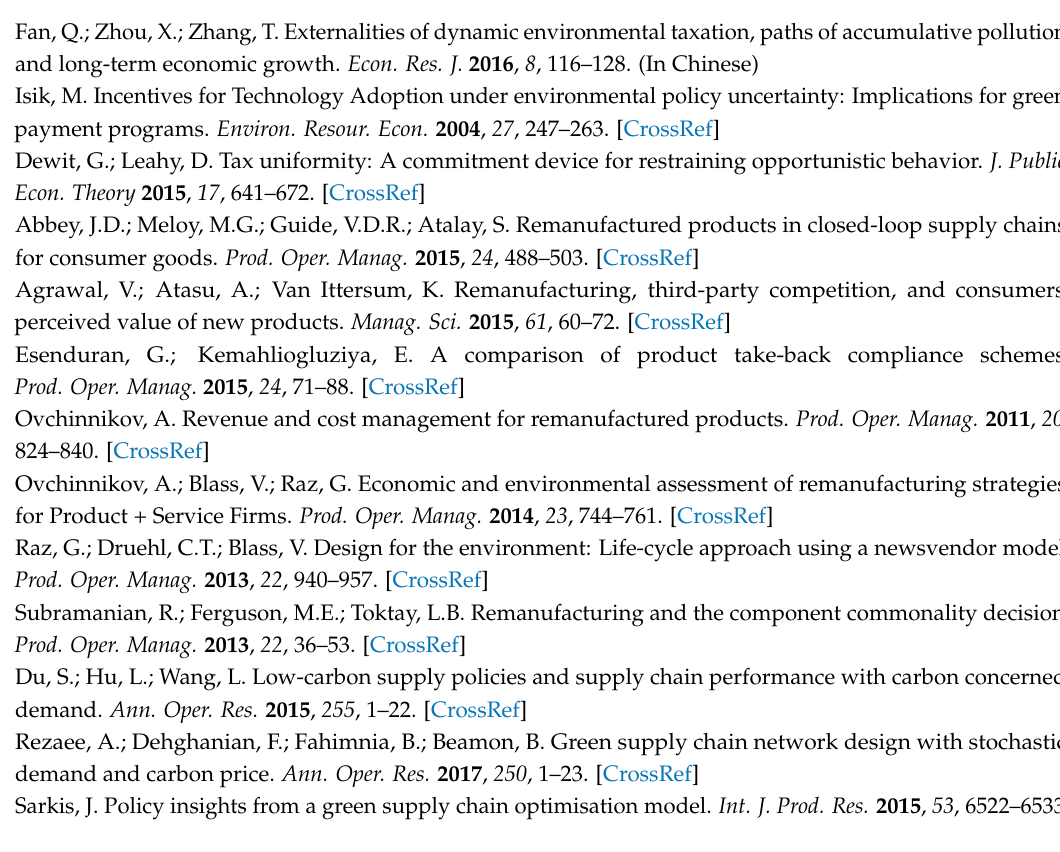
Figure A3. The curve of the function f 1 ( l ) or f 2 ( l ) in Sub-case